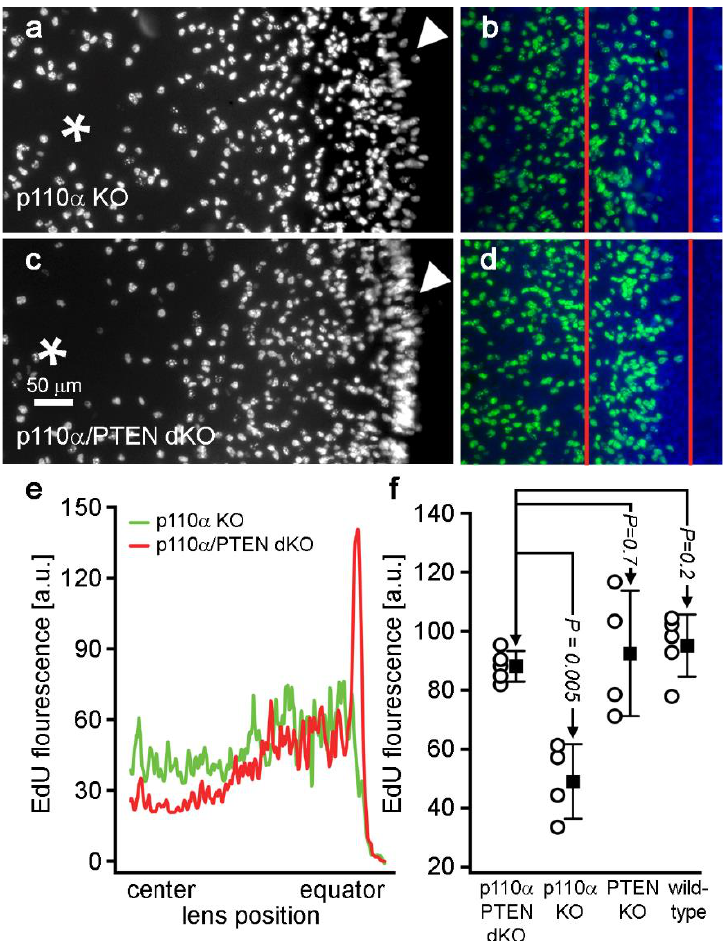
Figure 5. Germinative zone proliferation in double p110 α /PTEN knockouts was significantly in- creased compared to single p110 α knockout lenses. ( a – d ) Higher magnification views of postnatal day 0 lenses from single p110 α KO ( a , b ) and p110 α /PTEN dKO ( c , d ) looking onto the epithelial surface ( a , c , EdU fluorescence alone), or onto the lens edge ( b , d , EdU green, DAPI, blue). EdU-labeled cells are visibly increased in the germinative zone of p110 α /PTEN dKOs in both views (white arrowheads in a and c, red lines in b and d). ( e ) Line scans of the entire field of view in panels a and c confirmed the increase in EdU fluorescence in the equatorial germinative zone in dKO lenses. ( f ) Plots of mean values of peak EdU fluorescence (open circles are raw data, filled squares are means ± the SD) showed a significant increase ( p < 0.05) in p110 α /PTEN dKOs compared to p110 α KOs. There were no signifi- cant differences between p110 α /PTEN dKOs and PTEN KO, or wild-type lenses ( p > 0.5, two sample t -test). The center of the lens is indicated by an * in panels a and c. n = 4–5 lenses per genotype.